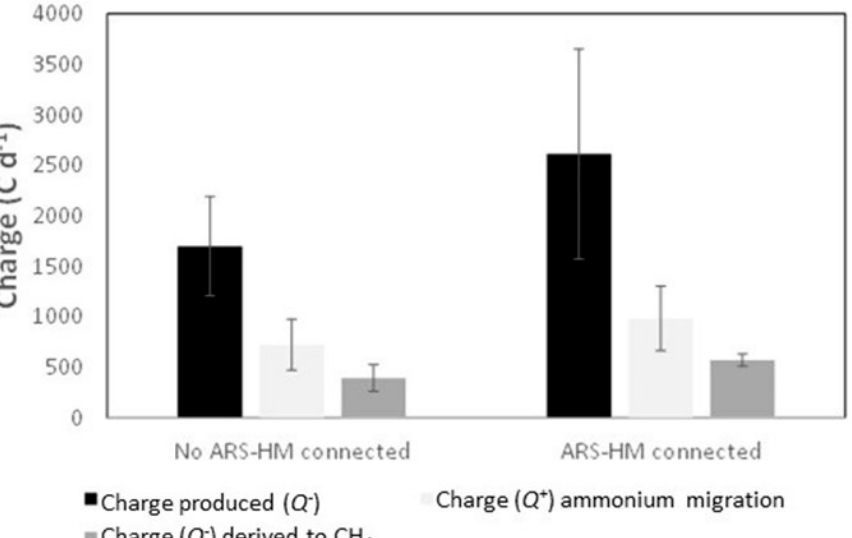
Figure 4. Comparison of the average daily charge production ( Q − ) to the transport of charge in the form of ammonium ( Q + ) transferred to the cathode compartment and the charge Q − derived to methane production in the biocathode. This charge ( Q − ) is externally supplied and accounts for the energy required for bio- gas upgrading and ammonium migration. Energy consumption in this MEC, accordingly to the applied potential and the intensity produced, was on average of 45 kWh m − 3 of methane produced. Previous work have reported energy consumption for methane pro- duction in electromethanogenic biocathodes of the same order of magnitude [11,15,47] and even values of 1 kWh m − 3 CH 4 in a medium-scale prototype [36]. For the migration of ammonium alone, the energy consumption was of 5 kWh kg − 1 of removed N. In this case, of concomitant electromethanogenesis and ammonia removal in the same MEC, the re- ported energy consumption is shared by both processes. There are several advantages of using hydrophobic membranes for ammonia recov- ery from electromethanogenic biocathodes, against stripping/absorption technology. On the first hand, although at a slow rate, N transfer is feasible at near to neutrality pH, with no need of alkali or temperature addition. A recent study has shown that operating hy- drophobic membranes at moderate alkaline conditions would prevent inorganic fouling on the membrane surface, besides being economically viable for the treatment of domestic wastewater treatment [48]. On the second hand, previous studies have reported a clear improvement in nitrogen recovery when using membranes by reducing nitrogen losses, that potentially occurred via condense water in the gas phase of a stripping column [24]. Furthermore, energy requirements are reduced, since no aeration is required. Finally, hy- drophobic membrane has been reported to prevent microorganisms transfer towards the absorbent, while air flow biomass from the biocathode could move with the gas flow and accumulate in the absorbent of the stripping system [24]. The MEC coupled to ARS-HM technology readiness level (TRL) presented in this study is TRL 4, since has been validated in lab-scale. However, other authors have devel- oped medium [36] and pilot scale systems [49], for the assessment of MEC and methane production. Also real-scale reactors are being currently developed, as described in a com- prehensive review recently published [20]. Besides, hydrophobic membranes are being assessed at pilot scale [50,51], thus it could be feasible to achieve a TRL 6 for the MEC